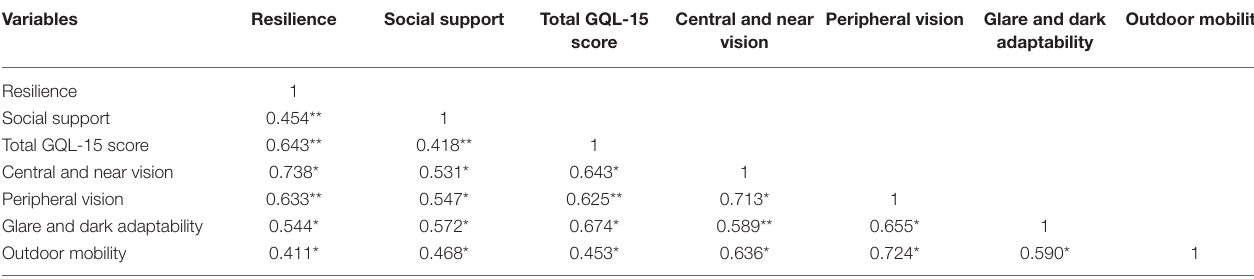
TABLE 3 | Correlation analysis of glaucoma patient quality of life, perceived social support, and resilience.